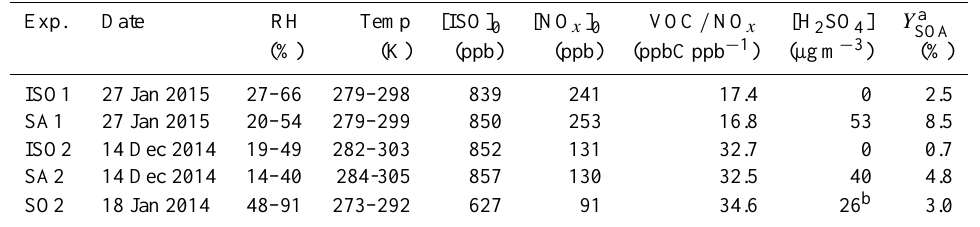
Table 1. Experimental conditions and resulting SOA data of the isoprene photooxidation experiments performed with and without inorganic acidic seed in the dual, outdoor UF APHOR chambers. Exp. Date RH Temp [ISO] 0 ISO1 27 Jan 2015 27–66 SA1 ISO2